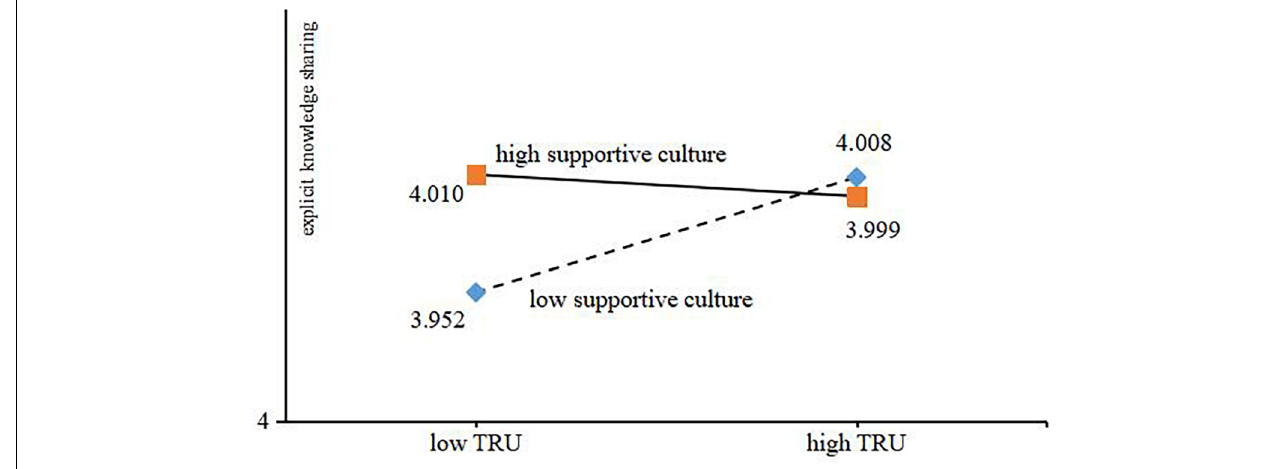
FIGURE 2 | Moderating effect of supportive culture.